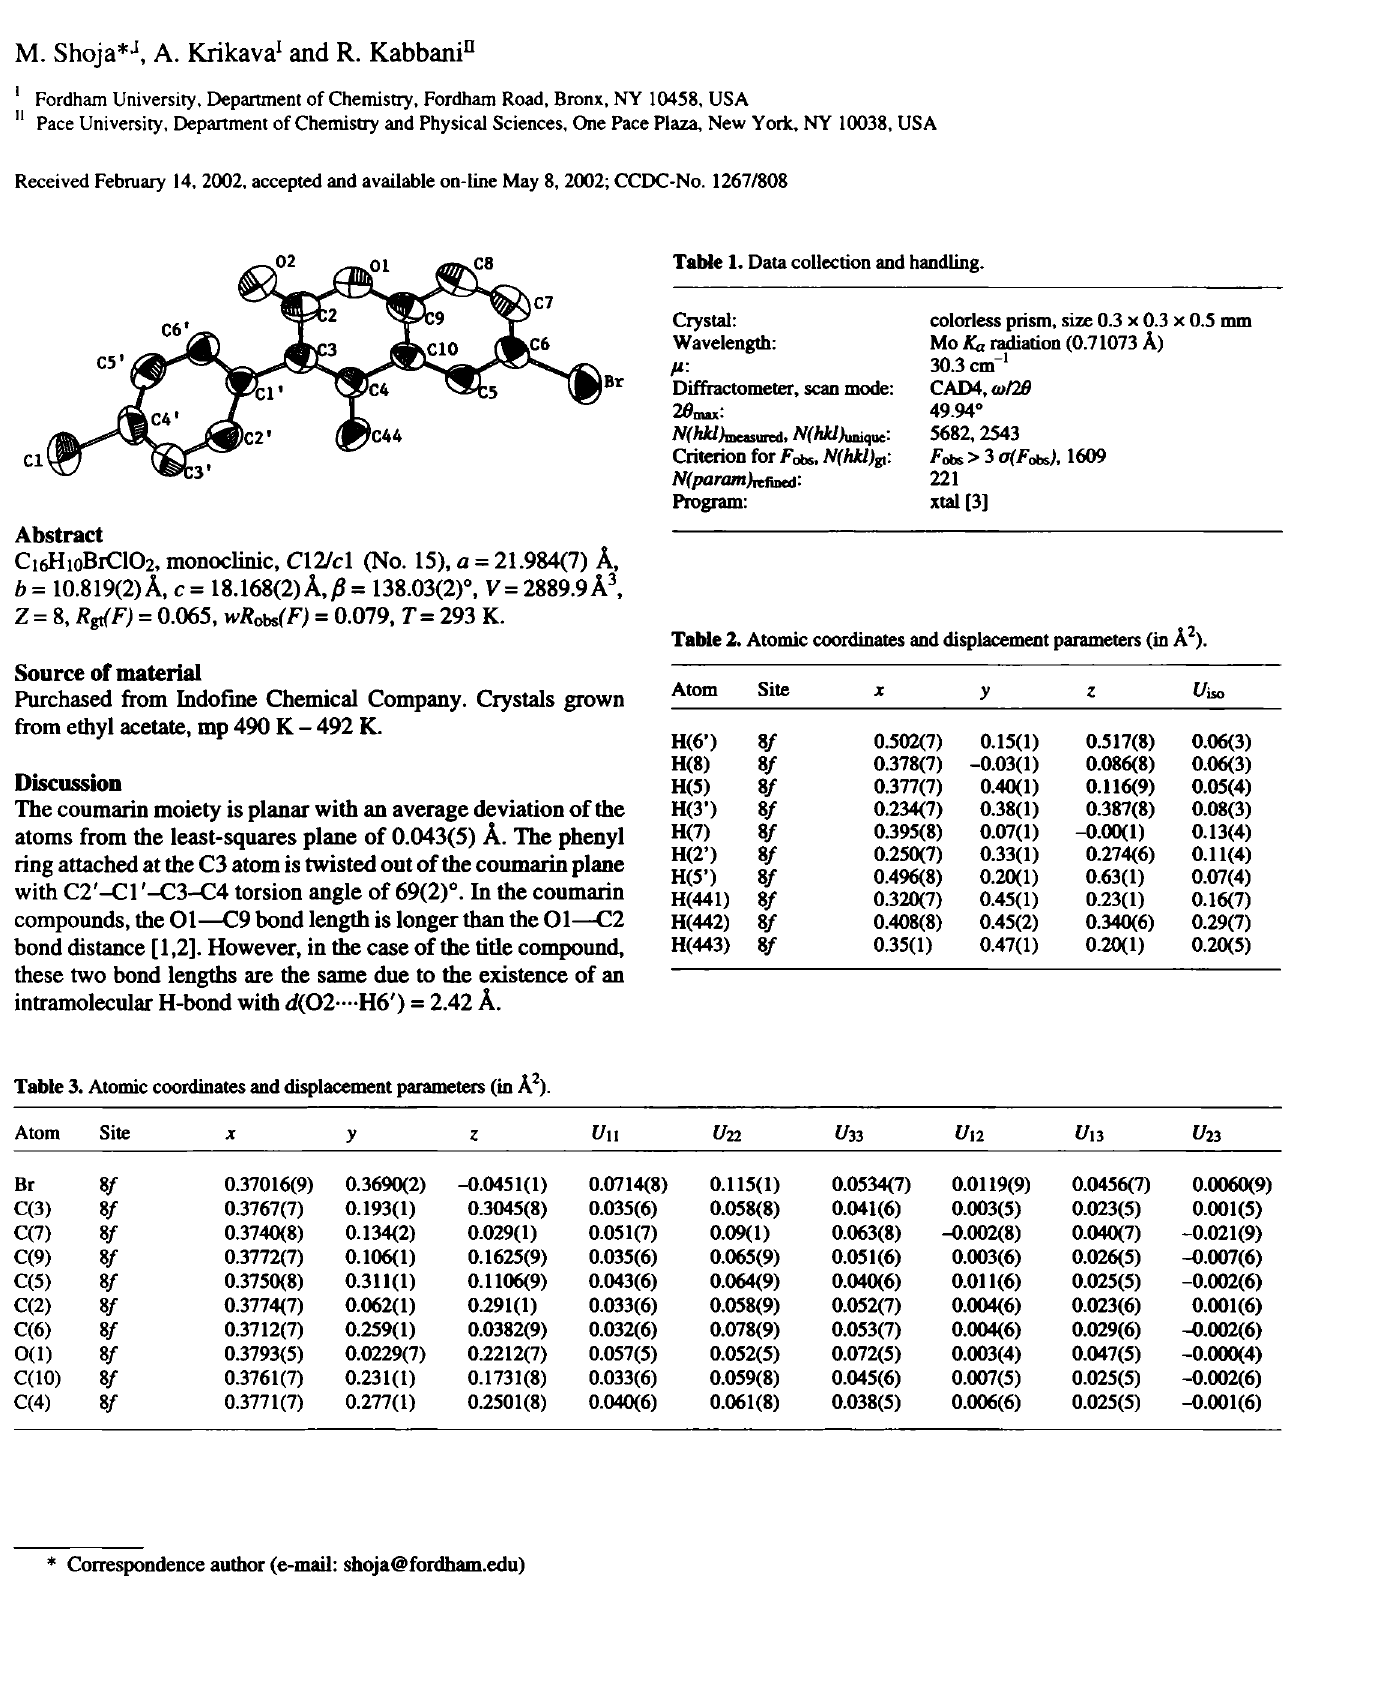
Table 1. Data collection and handling.